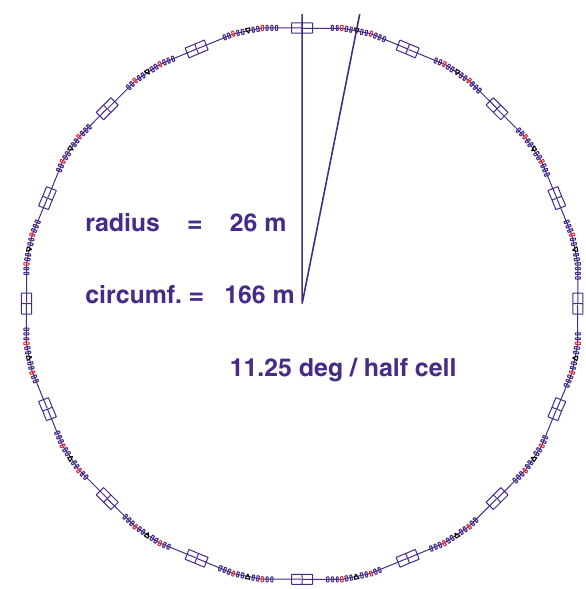
FIG. 42. (Color) Top view of a sixteen cell muon-cooling ring.